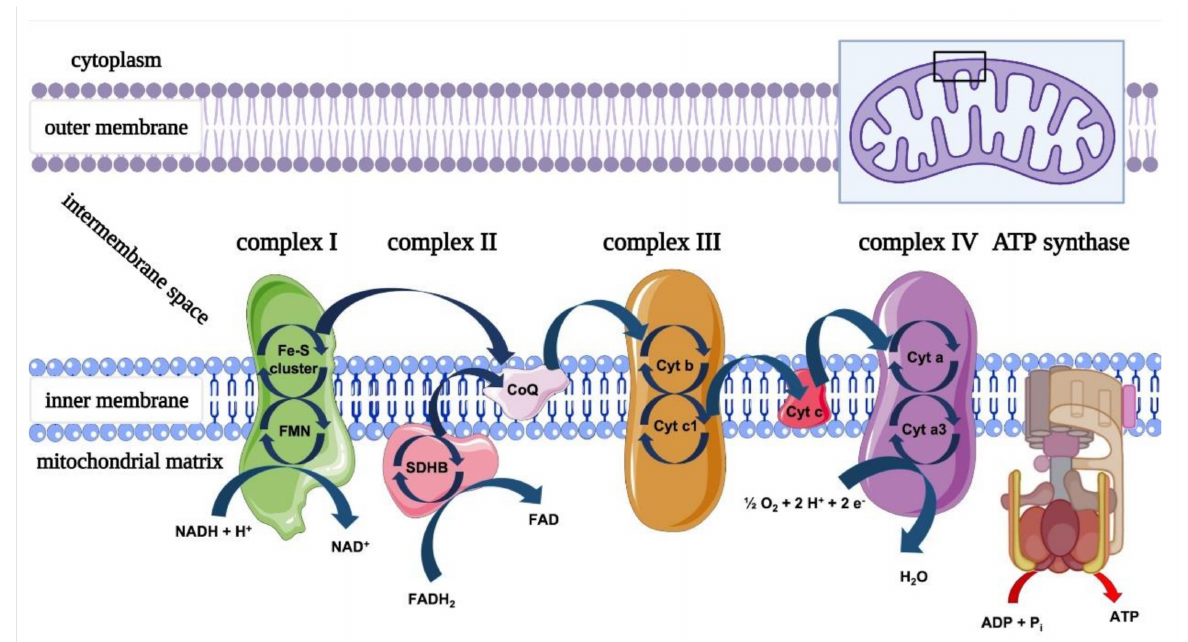
Figure 4. Organization of the oxidative phosphorylation (OxPhos) machinery. The respiratory chain, located in the inner mitochondrial membrane, consists of five multimeric protein complexes: reduced nicotinamide adenine dinucleotide (NADH) dehydrogenase–ubiquinone oxidoreductase (complex I) contains eight Fe-S clusters involved in the transfer of electrons from reduced flavin mononucleotide (FMNH2) to ubiquinone; succinate dehydrogenase–ubiquinone oxidoreduc- tase (complex II) contains a heme b prosthetic group in its anchor domain, which is essential for the structural integrity and function of the complex; ubiquinone–cytochrome c oxidoreductase (complex III) contains a cytochrome b subunit with two heme moieties, a cytochrome c1 subunit with one heme and a Rieske protein subunit (UQCRFS1) with a [2Fe-2S] cluster, and finally, the cytochrome c oxidase (complex IV), which mediates the final step in the electron transport chain, by catalysing the reduction of oxygen to water. It contains two heme-a moieties and two Cu centres, all of which participate in the electron transfer process to the ATP synthase. Image created with